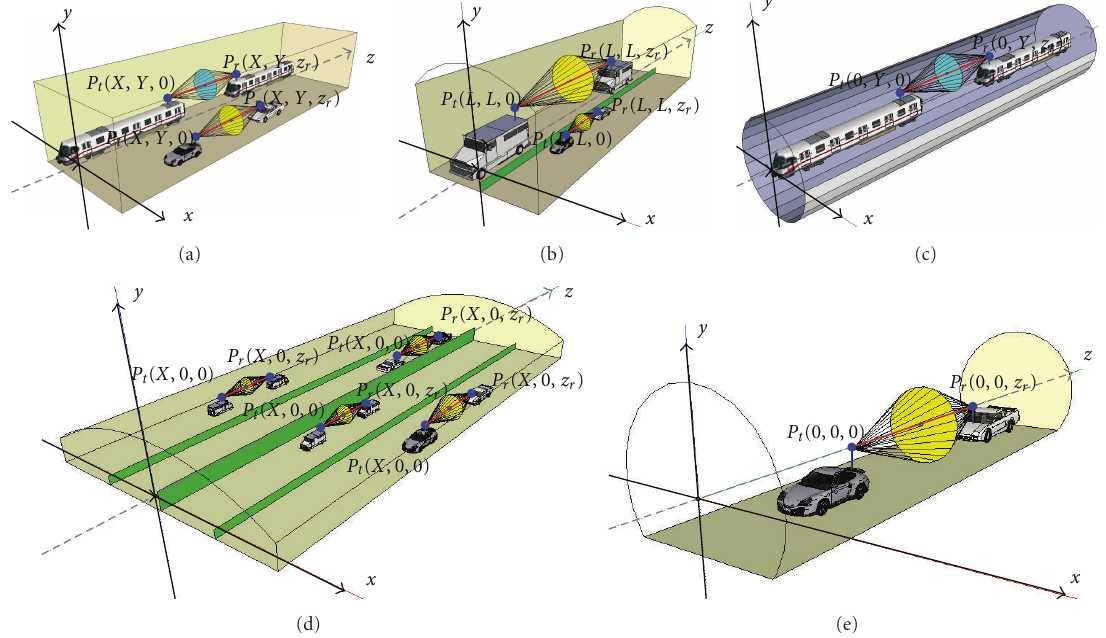
Figure 8: (a) specific situation one; (b) specific situation two; (c) specific situation three; (d) specific situation Four; (e) specific situation